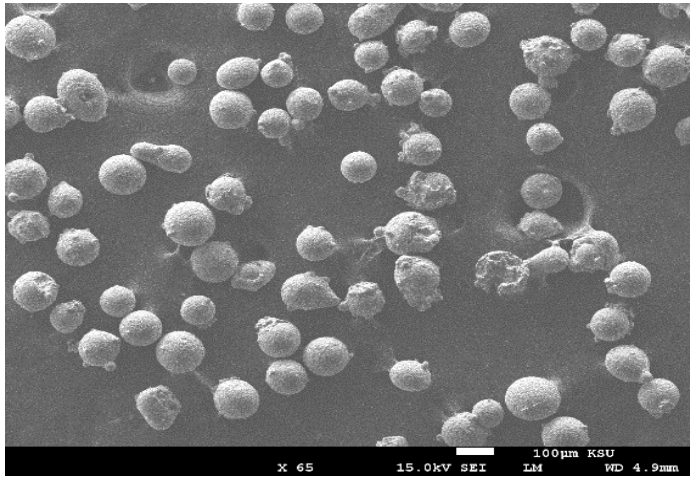
Figure 2. Scanning electron microscopy image of the powder particles before